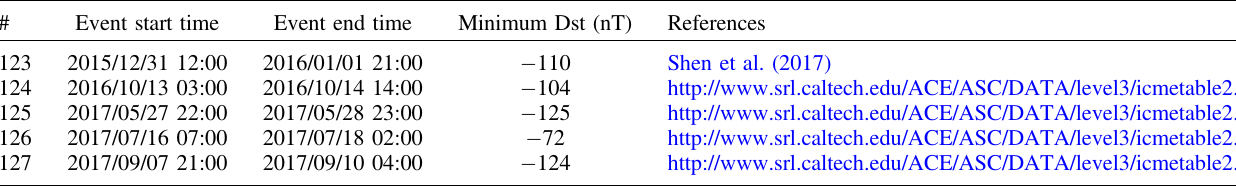
Table A.1. (Continued)